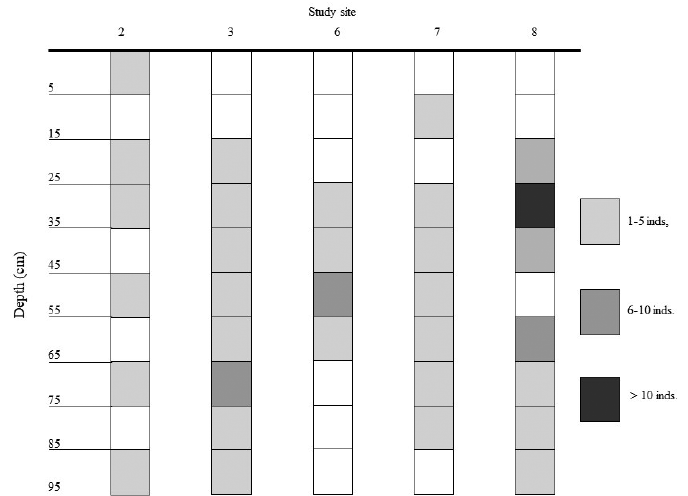
Figure 3. Depth distribution of Mesoniscus graniger . Site 1 is out of the species range. Study sites 4 and 5 were not depicted, because whole depth gradient was not represented (see locality description).